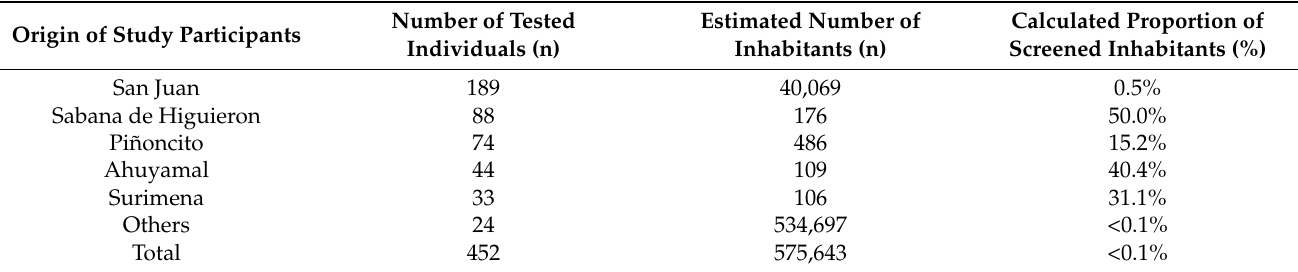
Table 1. Proportion of assessed individuals per study